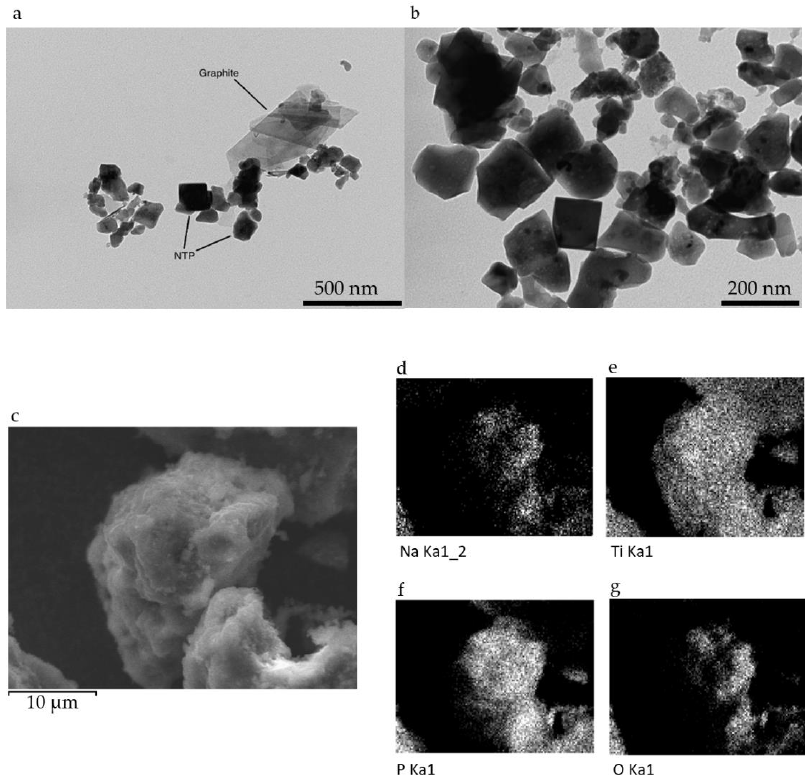
Figure A3. ( a , b ) TEM images of NTP powder, ( c ) SEM image of NTP and ( d – g ) elemental distribu- tion of Na, Ti, P, and O, respectively.